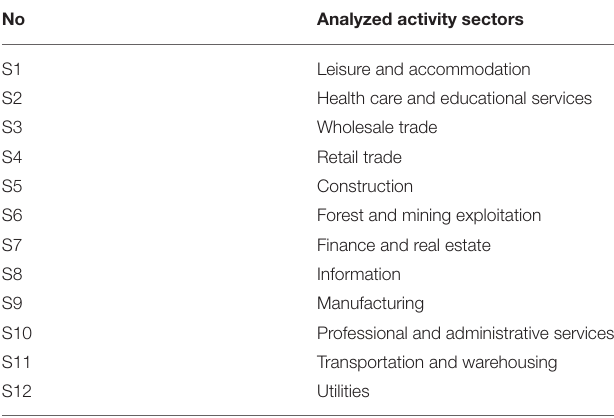
TABLE 1 | Adapted sectoral NAICS classification used in this study.